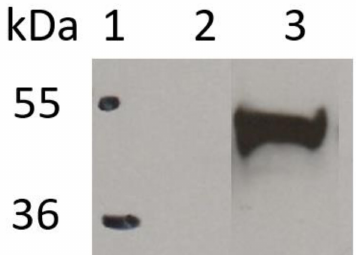
Figure 3. Western blot analysis. Lane 1: protein ladder, lane 2: negative control (transfection without a plasmid), lane 3: scFv-HER2_gp41 protein (transfection with plasmid X1665). Western blot detection was performed using an HRP-conjugated anti-HA polyclonal antibody (1:2500). Visualization of bands was carried out using the ECL ®